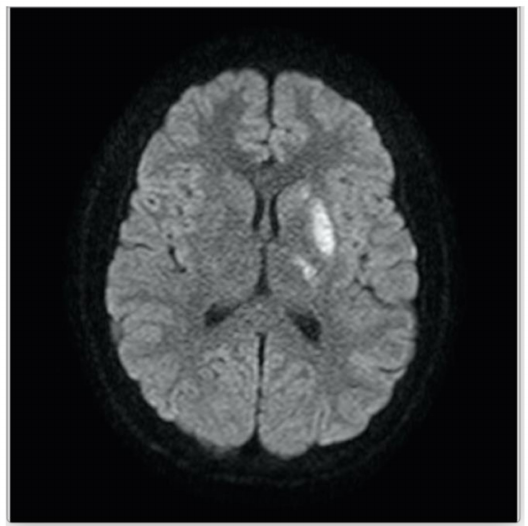
Figure 1. Diffusion weighted image shows restricted diffusion in the left lentiform nucleus, ventrolateral thalamus and caudate head, consistent with acute ischemia or infarct in the distribution of the left middle cerebral artery (MCA).